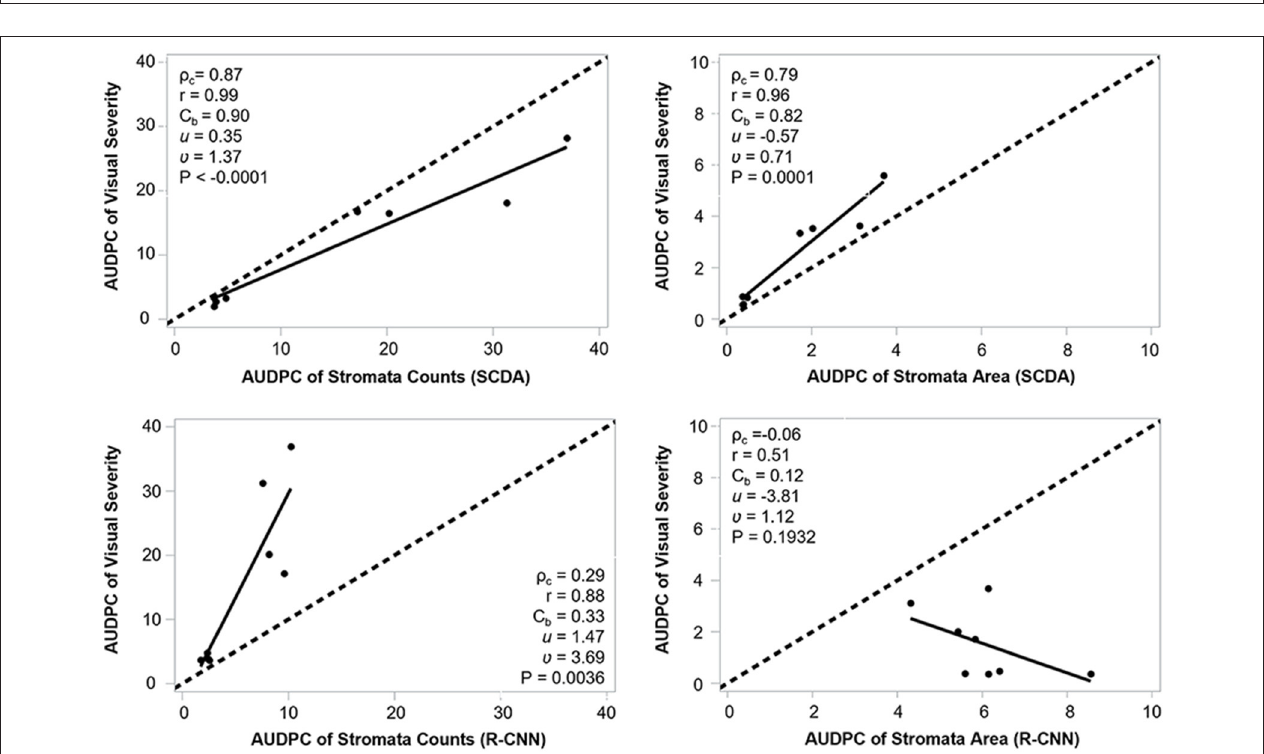
FIGURE 11 | Agreement of AUDPC between visual disease severity vs stromata counts and proportion of leaf covered by stromata generated by SCDA and mask R-CNN.